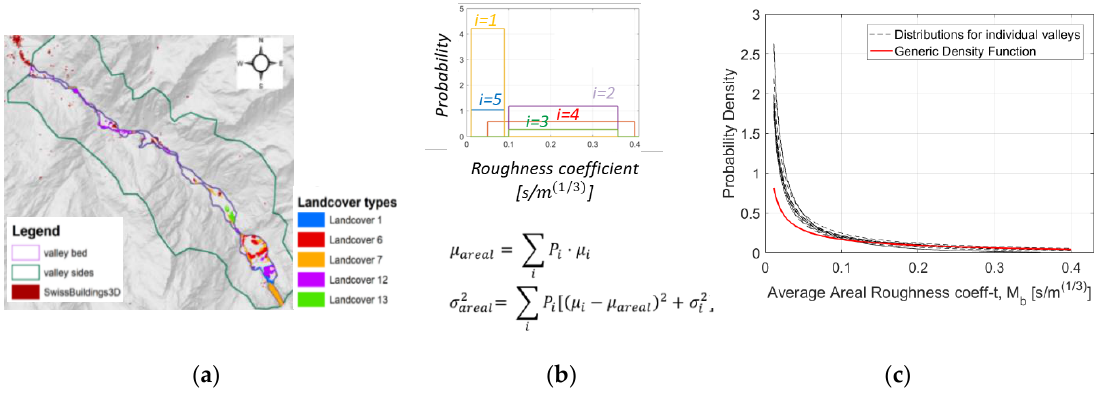
Figure 7. ( a ) Mauvoisin dam downstream area with land cover types within the valley bed; ( b ) workflow for calculation of average areal roughness distribution; ( c ) individual distributions of average areal roughness coefficient, M b , for each dam (dashed lines) and their generic density function (red solid line). Table 6. Information about the marginal distributions specified for the input of the metamodel. Table 5. Roughness coe ffi cients for di ff erent types of land